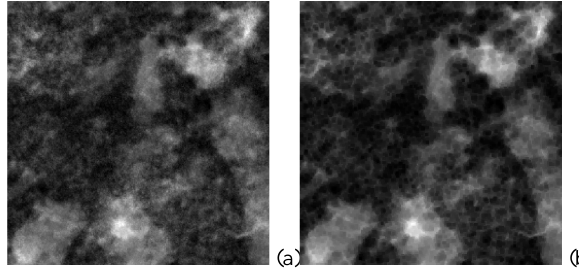
Fig. 2. The obtained result for a soil image: (a) the CT soil image in grey scale; (b) the results after a morphological erosion